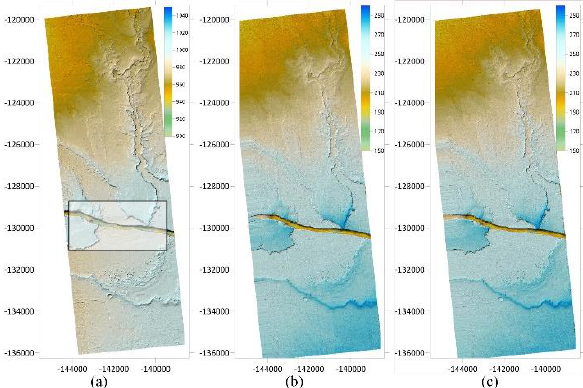
Figure 8. Comparison of DEM in the channel areas. (a) AU, (b) ASP and (c) Planetary3D. It should be noted that DEM from AU has a different datum, therefore the height range and color scale are different from those of ASP and Planetary3D. The rectangle indicates the enlarged area in Figure 9.